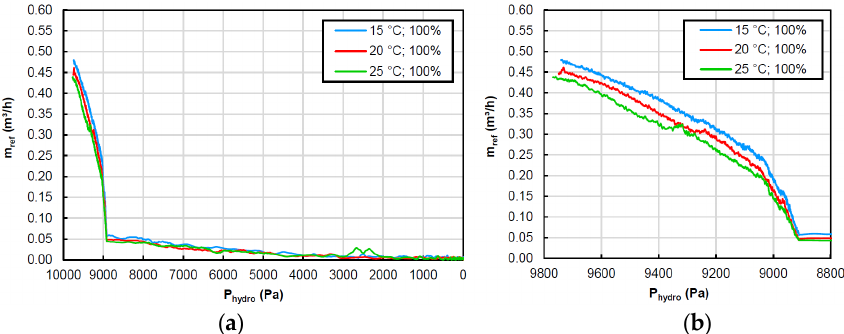
Figure 6. Flow rate variation by varying hydrostatic pressure for the whole evaporation process ( a ) and only for the initial phase ( b ).